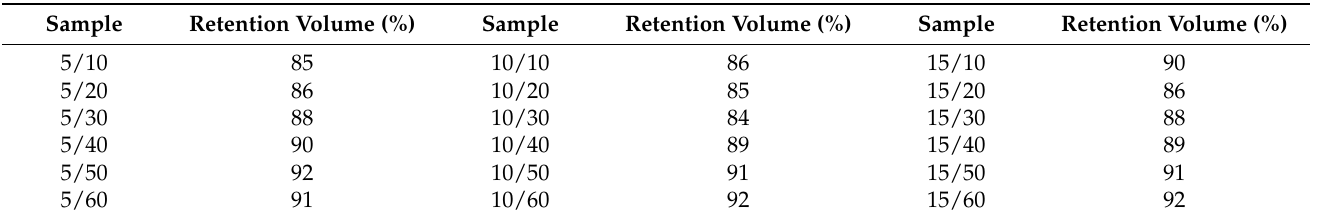
Table 3. The retention volume of modified chitosan nonwovens after treatment in solutions of acetic acid and ethanol—procedure with rinsing.